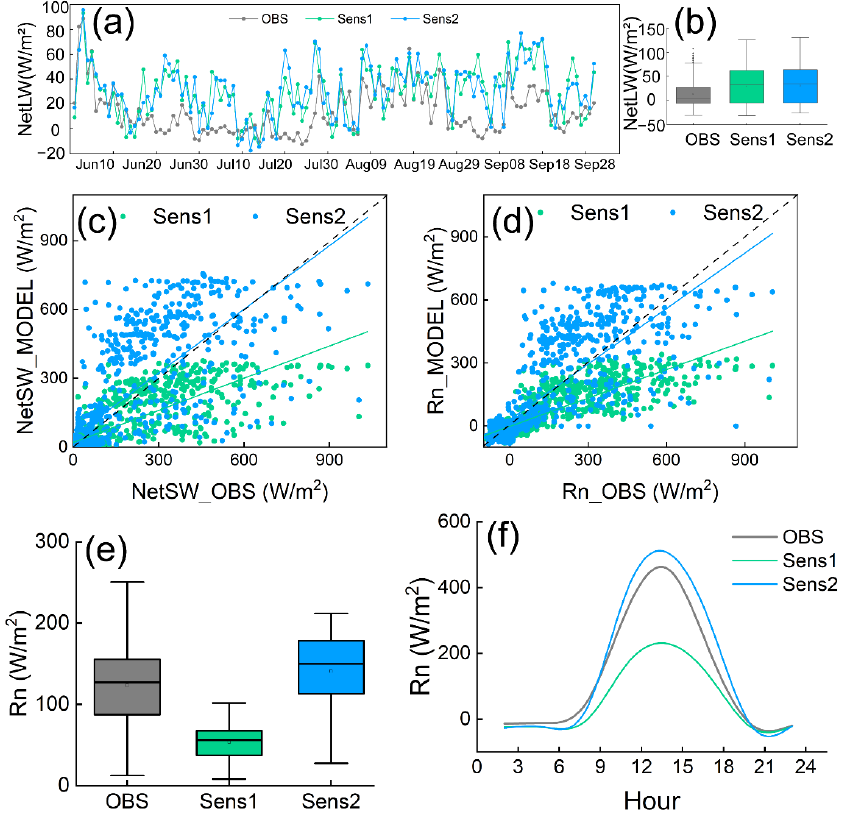
Figure 4. Comparison of the net longwave radiation ( a ) daily mean NetLW; ( b ) instantaneous NetLW, net shortwave radiation; ( c ) instantaneous NetSW; and net radiation ( d ) instantaneous Rn; ( e ) daily mean Rn), and the diurnal variation in instantaneous net radiation ( f ) between the observations (OBS: grey) and model estimates (Sens1: green; Sens2: blue). The grey dashed line denotes the perfect linear fit line of y = x, the green solid line denotes the linear fit between the observation and Sens1 estimates, and the blue solid line denotes the linear fit between the observation and Sens2 estimates in ( c ) and ( d